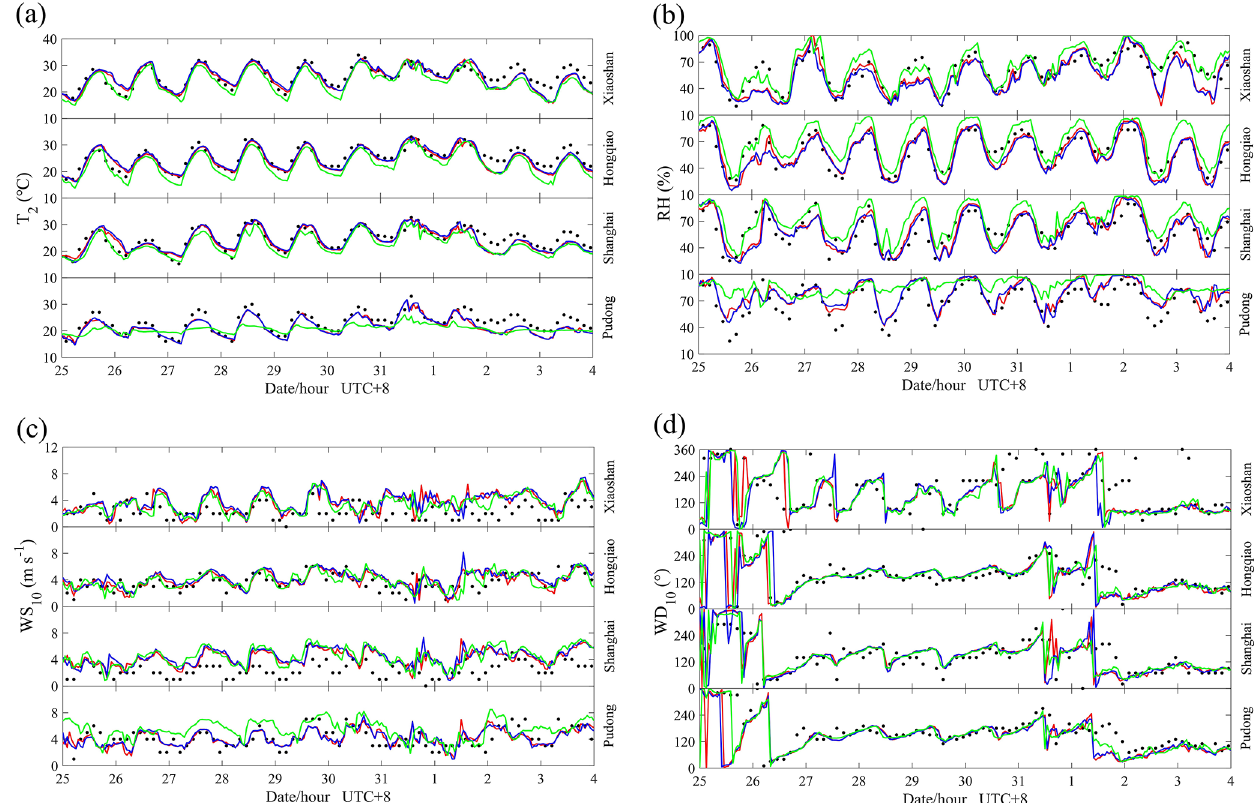
Figure 5. Time series of (a) T 2 , (b) RH, (c) WS 10 and (d) WD 10 for observations and simulations at different weather stations. The black dots are the surface observations. The simulation results of MODIS_noAH, USGS_noAH and MODIS_AH are shown in red, green and blue lines,